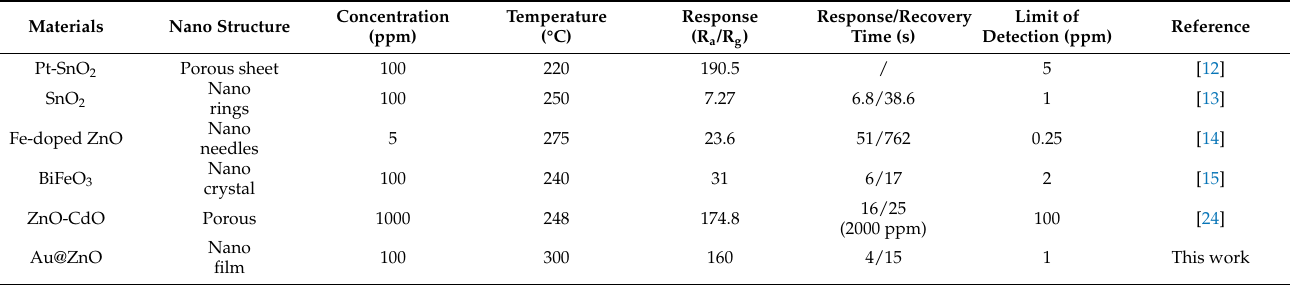
Table 2. Comparisons with the sensing properties of MOS-based IPA sensors reported in previous